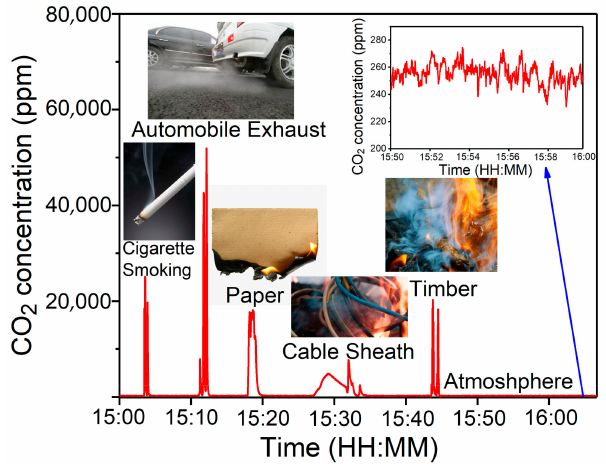
Figure 7. CO 2 detection from several sources with the reported QCL based CO 2 sensor system on the HIT campus, Harbin, China (Latitude and longitude are: 45 ◦ 43 (cid:48) N / 126 ◦ 37 (cid:48)